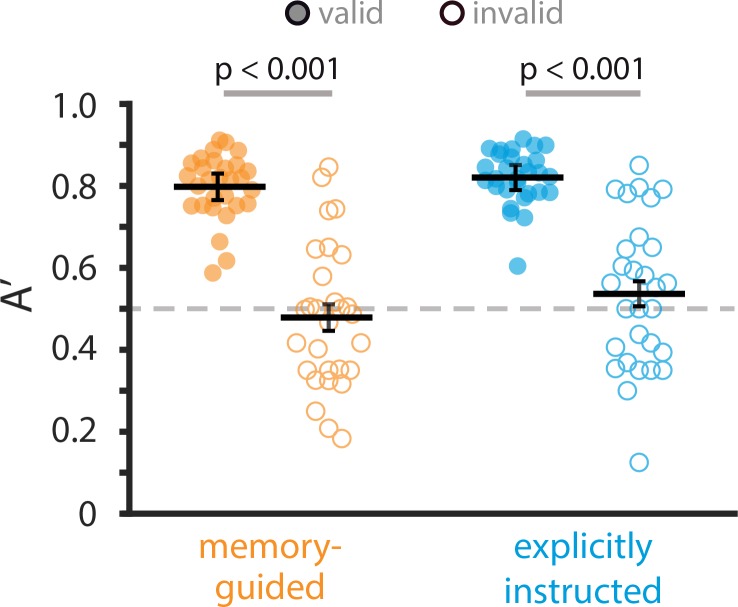
Behavioral results.Sensitivity (A’) in detecting (art or room) matches, shown separately for each task (memory-guided, explicitly instructed) and for valid vs. invalid trials (filled and open circles, respectively). Circles are individual participants. Solid lines show average A’ across participants, and error bars indicate the standard error of the mean for the within-participant valid – invalid difference. The dashed line indicates chance performance (A’=0.5). A’ was higher on valid vs. invalid trials and was not significantly different between the memory-guided and explicitly instructed tasks.